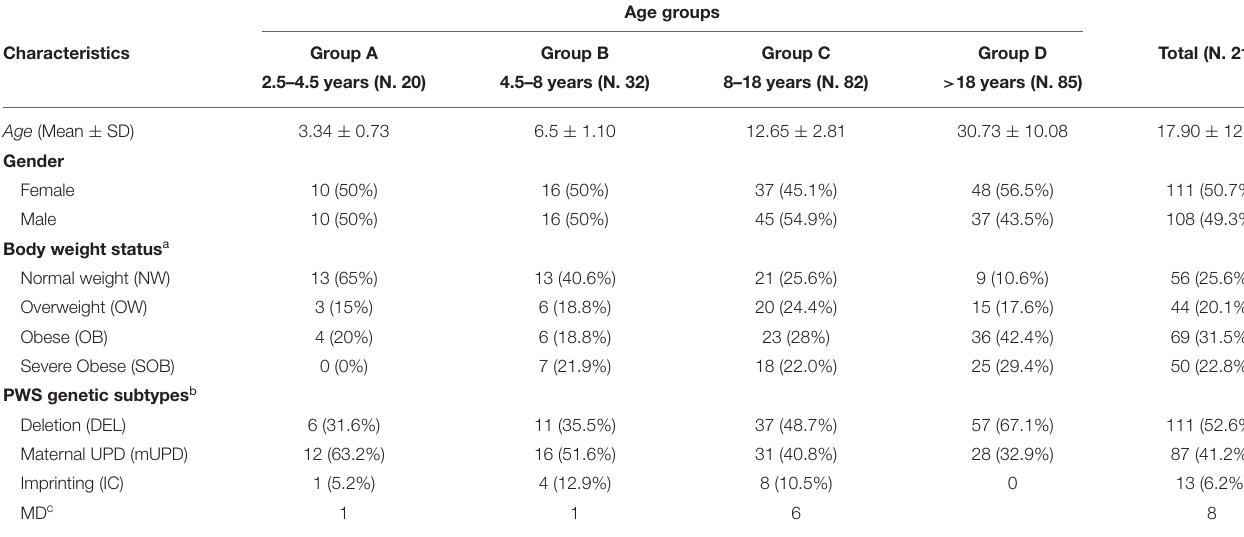
TABLE 1 | Characteristics of 219 individuals with PWS participating in the study across age